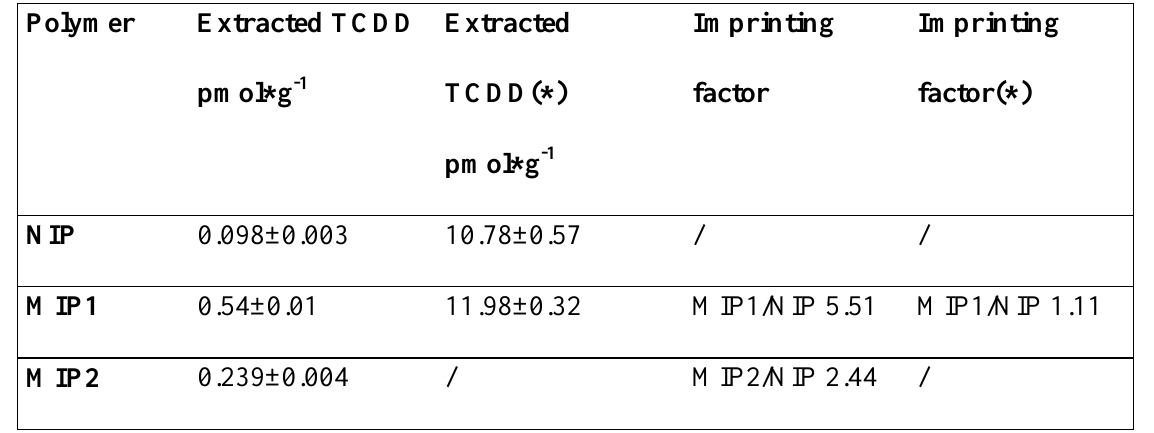
Table 2. Results of TCCD re-binding test (triplicate experiments) and comparison with literature